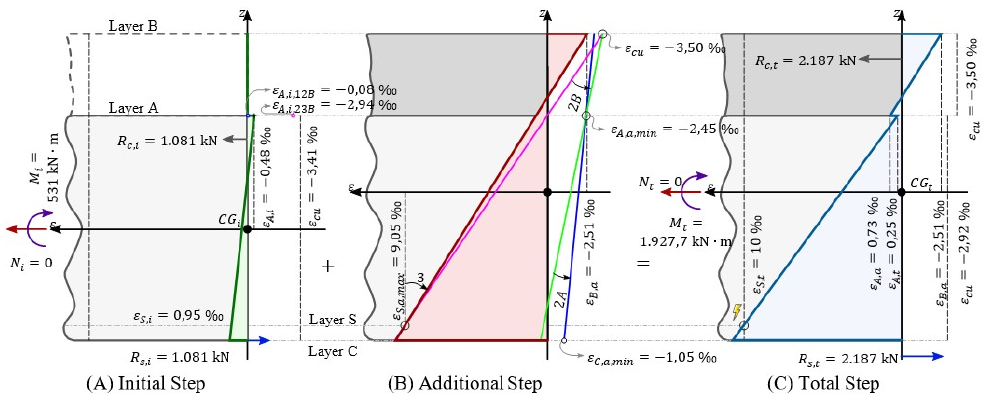
Figure 14. Strain diagram in ULS for the